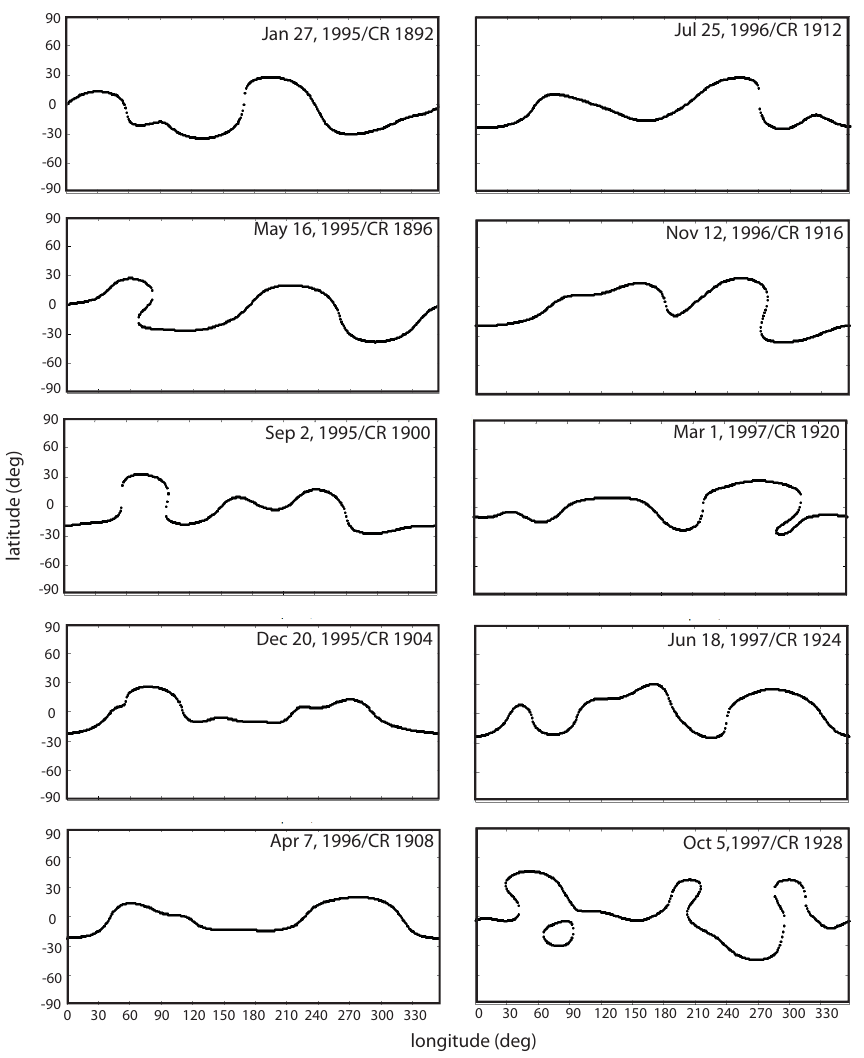
Fig. 4. Source surface synoptic maps from the Mount Wilson Observatory for selected Carrington rotations during the SC 22 minima. The black line indicates the neutral line. The date indicated gives the start time of each Carrington